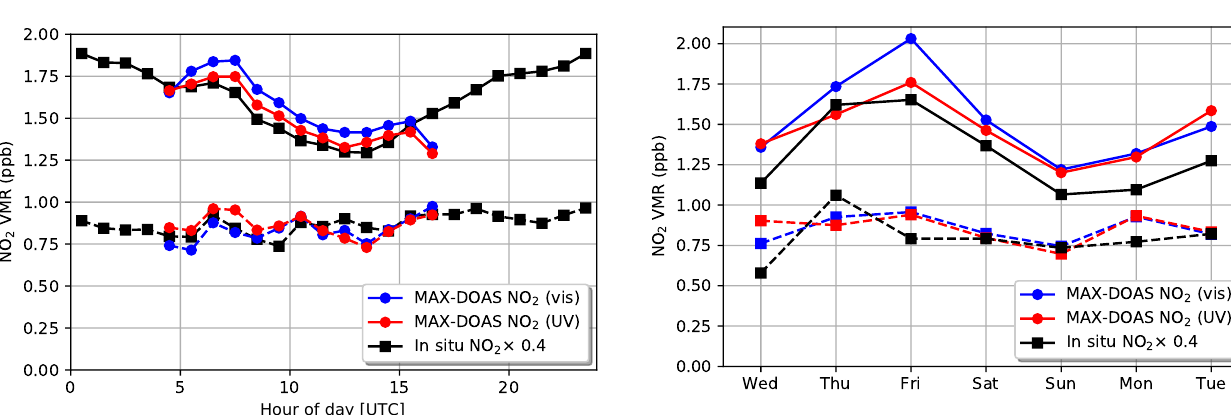
Figure 15. Average weekly cycle of MAX-DOAS (UV and visible) and in situ NO 2 volume mixing ratios for all measurements (solid lines) and for a subset of measurements with wind from the open North Sea (dashed lines). For a better visual comparability, the in situ values are scaled by a factor of